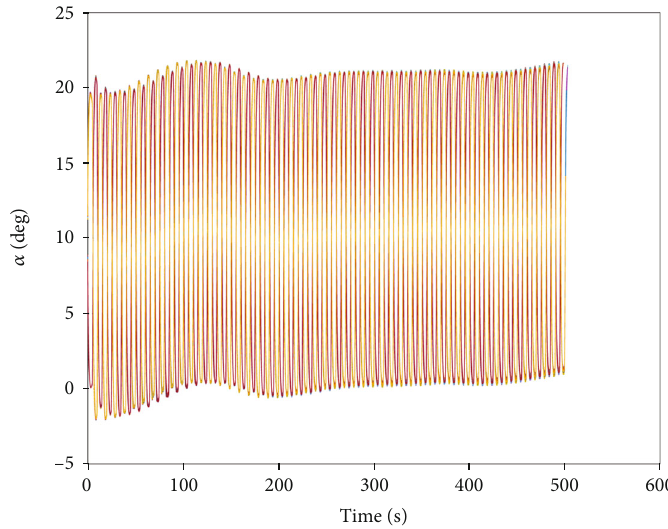
Figure 31: Angles of attack in the Monte Carlo